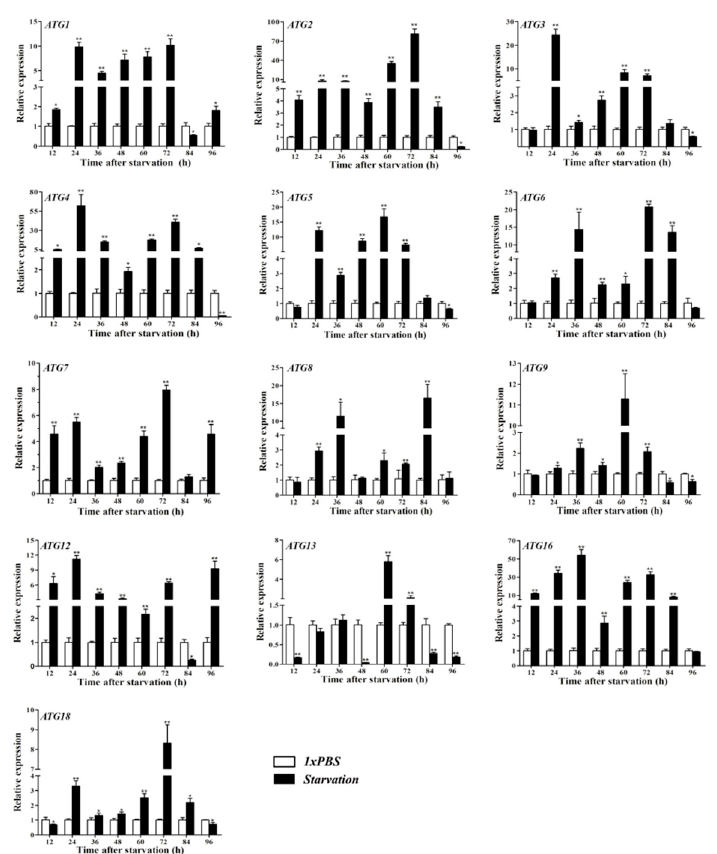
Figure 8. Expression patterns of HvATGs after 96 h of starvation (n = 50 larvae in each biological replicate). Expression levels of HvATG1 , HvATG2 , HvATG3 , HvATG4 , HvATG5 , HvATG6 , HvATG7 , HvATG8 , HvATG9 , HvATG12 , HvATG13 , HvATG16 , and HvATG18 . Error bars mean ± standard error of three biological replicates calculated by two-way analysis of variance and Students’ t-test. * p < 0.05, ** p <